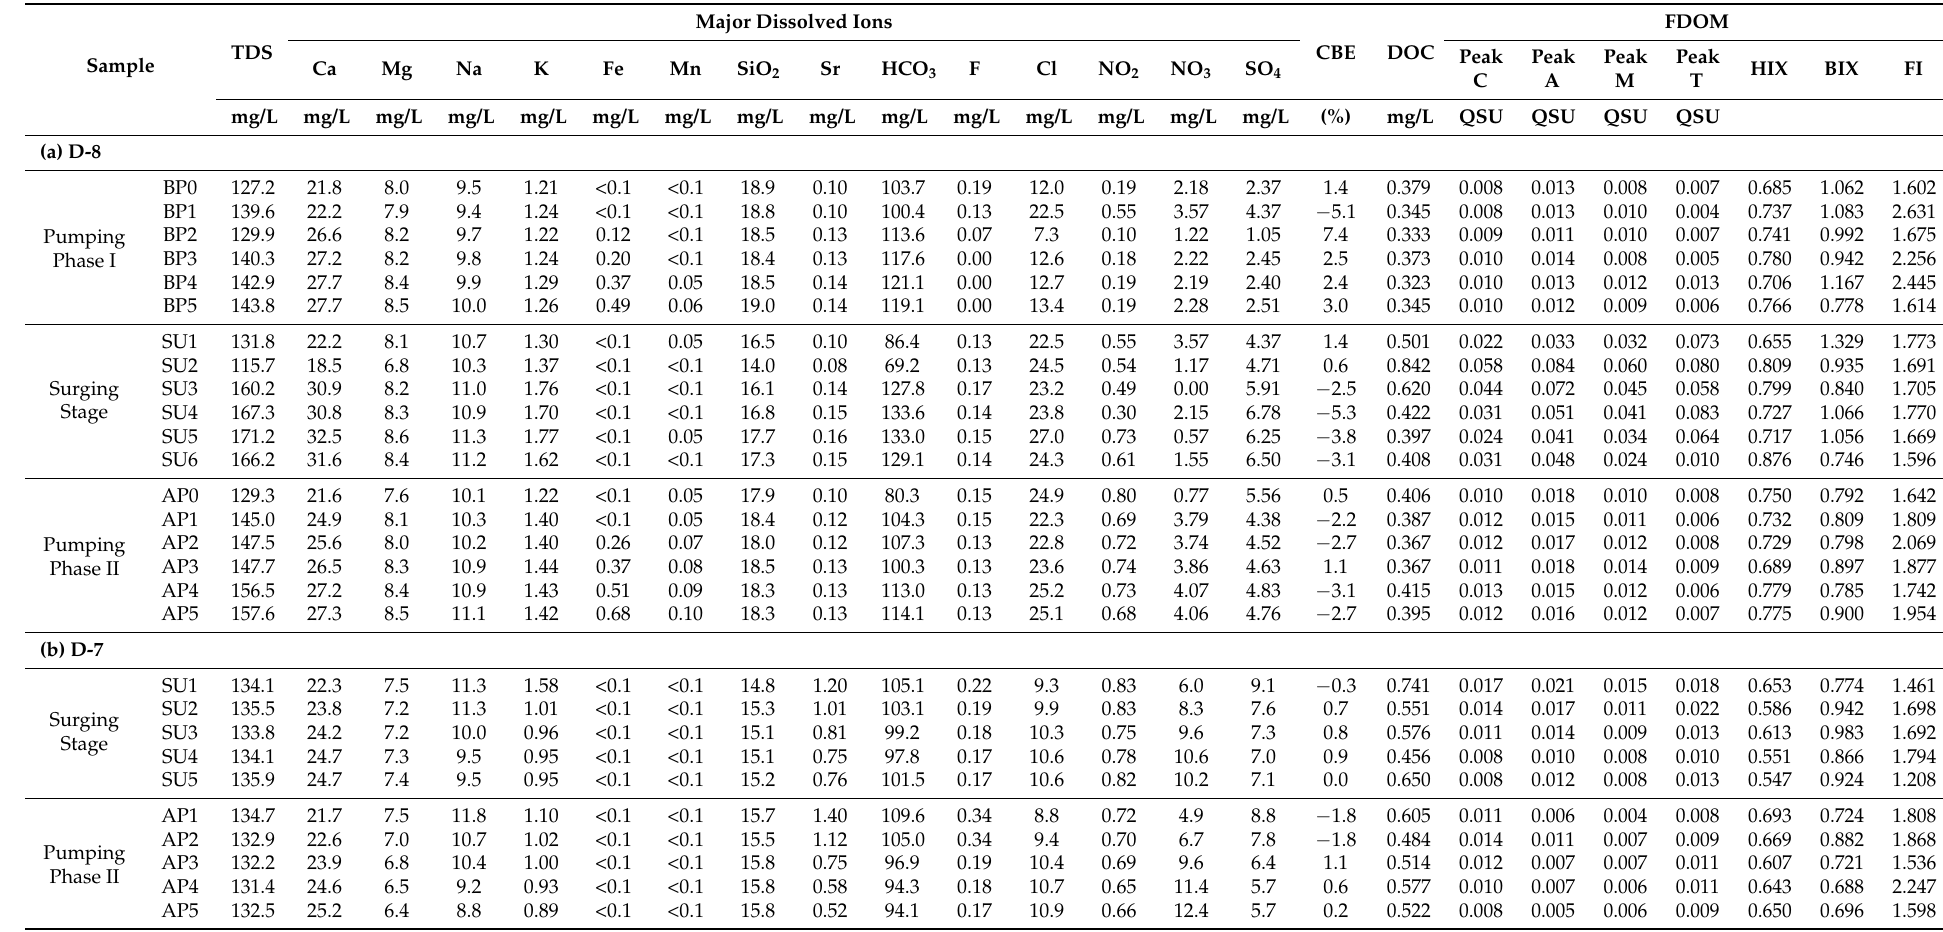
Table 4. The analysis of results from dissolved ions and dissolved organic matter in groundwater collected during surging and pumping